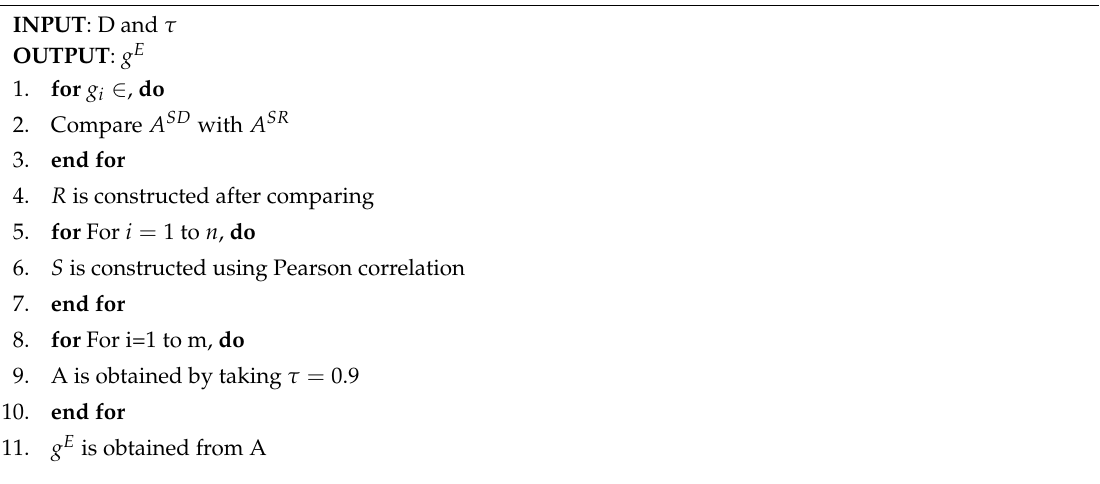
Algorithm 1: Pseudocode of the gene co-expression network’s